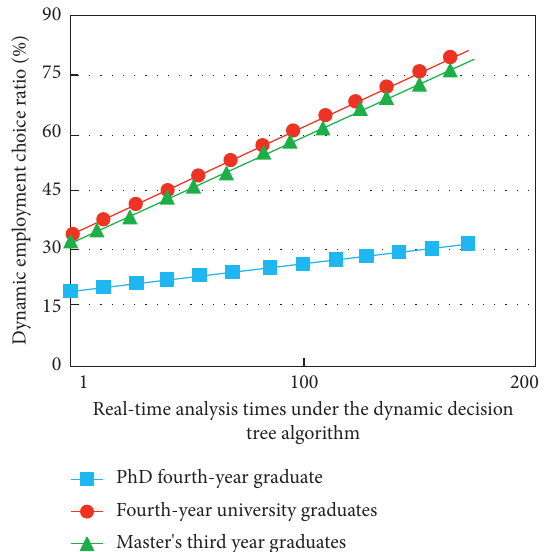
Figure 3: Simulation analysis results of employment of